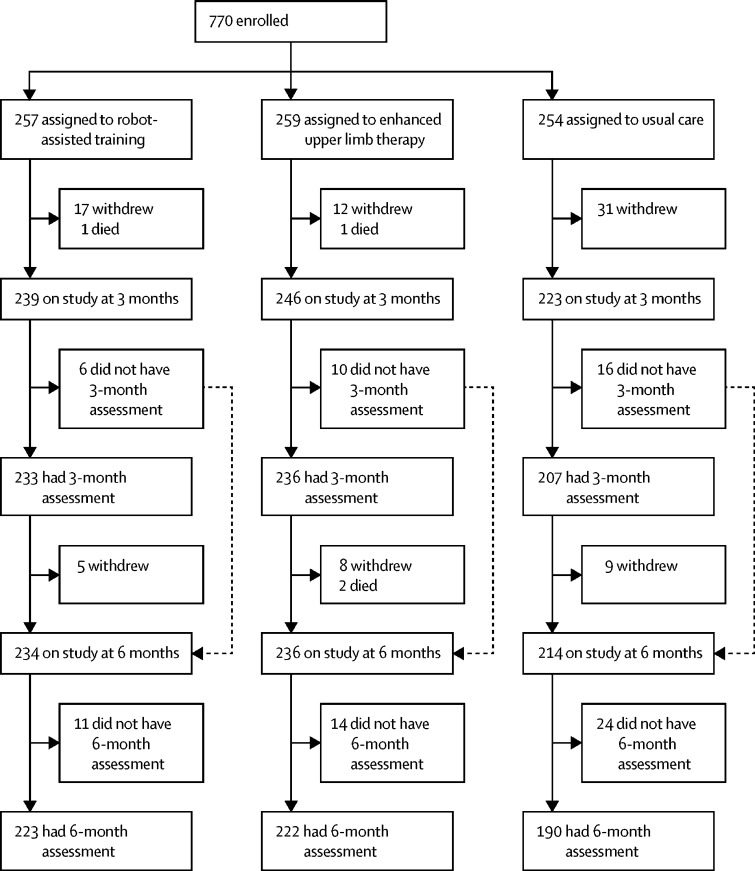
Trial profileAll participants assigned to intervention groups began their trial intervention. Reasons for withdrawals and missed assessments at 3 months and 6 months are in the appendix.